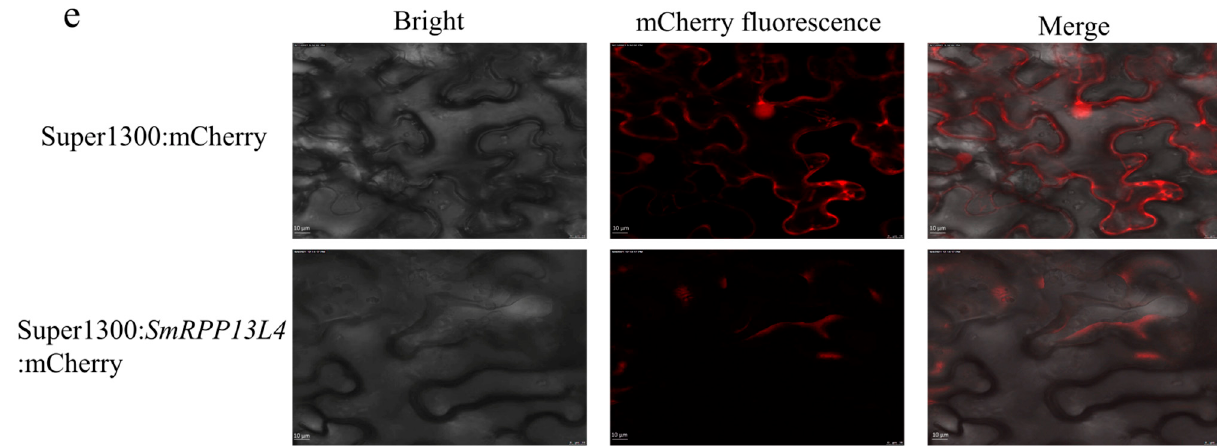
Figure 9. Functional verification of SmRPP13L4 gene. ( a ) The disease grade aboveground in BC01 after silencing SmRPP13L4 gene. ( b ) SmRPP13L4 gene expression after silencing SmRPP13L4 in stem. The bar plots and error bars represent averages and standard errors for three repeated samples under t -test. ( c ) The expression of SmRPP13L4 gene in BC01 root at different times of R. solanacearum infection. The points and error bars represent averages and standard errors for three repeated samples under Duncan’s test. ( d ) Expression of SmRPP13L4 gene in different tissues of BC01. The bar plots and error bars represent averages and standard errors for three repeated samples under Duncan’s test. ( e ) Subcellular localization of SmRPP13L4 gene. Note: capital letters show significance at the 0.01 level.